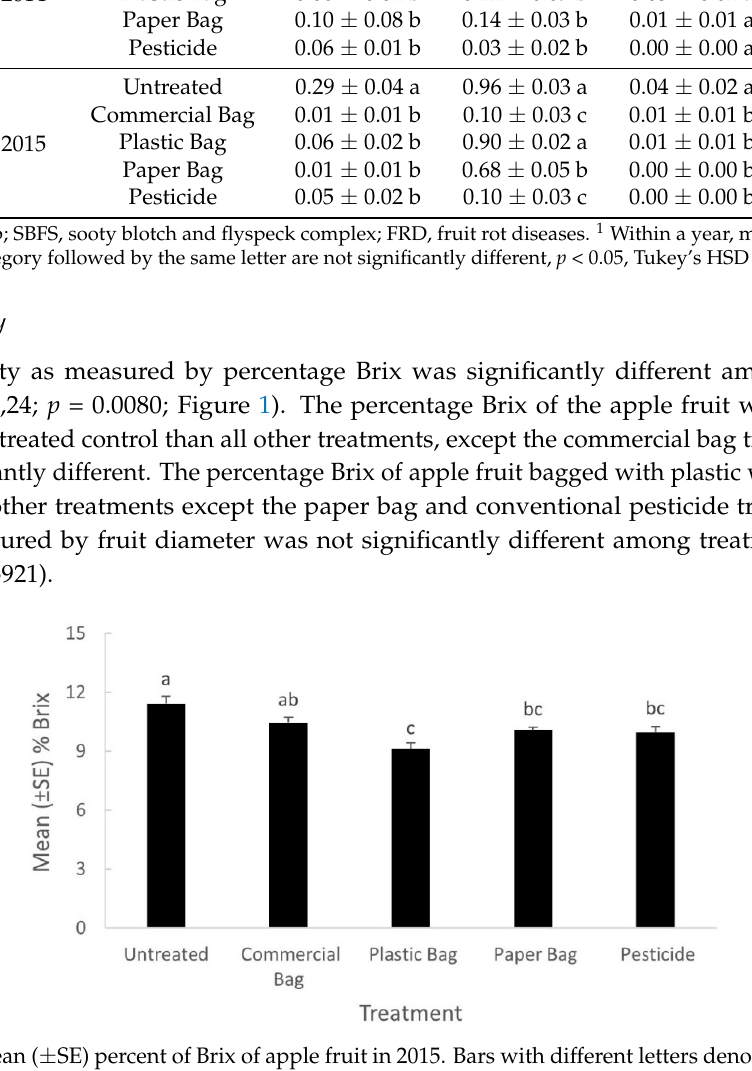
Figure 1. Mean ( ± SE) percent of Brix of apple fruit in 2015. Bars with different letters denote significant differences among treatments (Tukey’s HSD test, p ≤ 0.05).